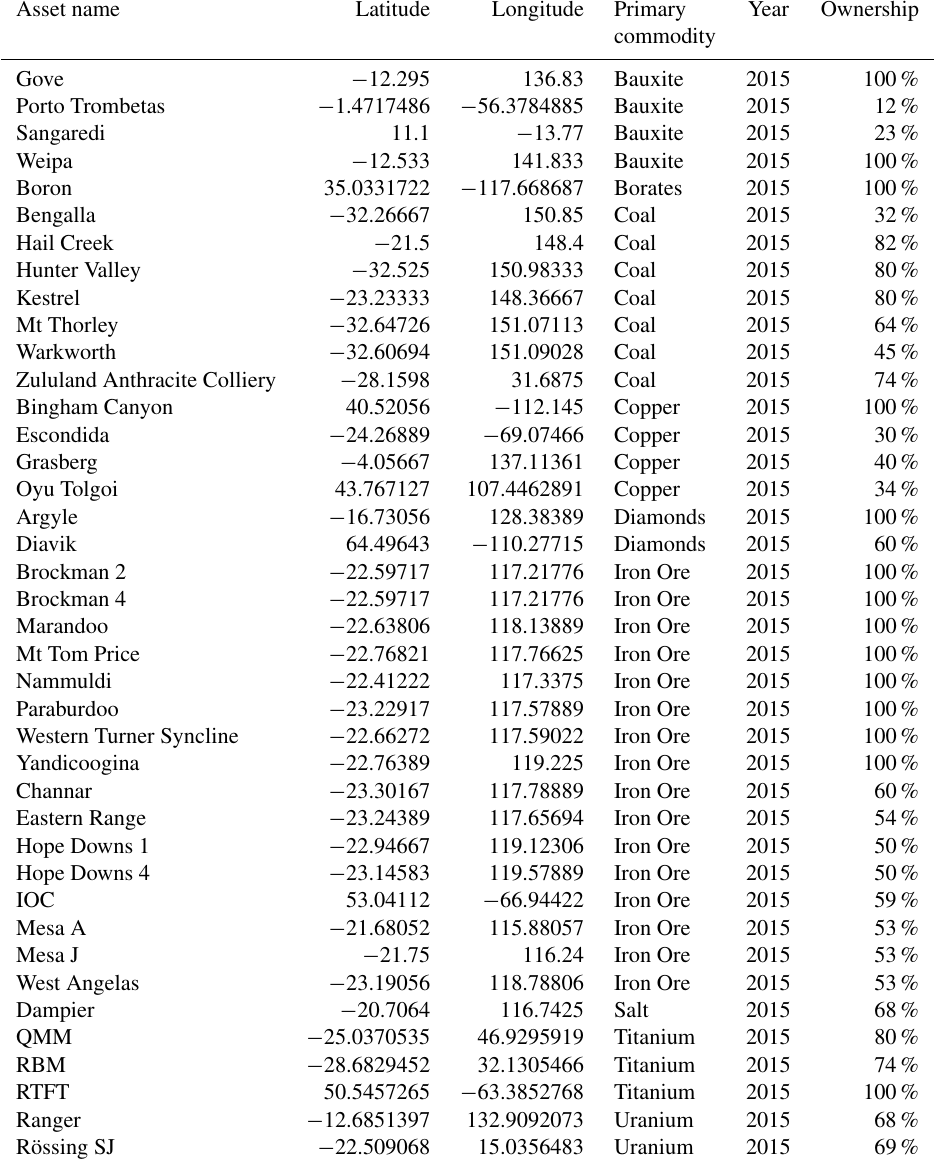
Table A4. 2015 mining asset coordinates for Rio